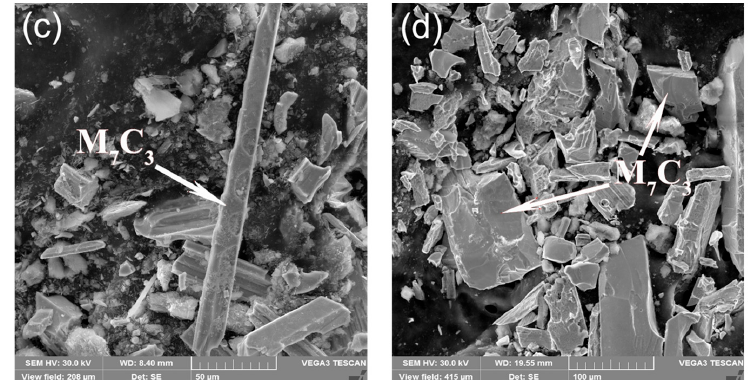
Figure 9. SEM microgrphs of the surface of samples and primary carbides: ( a ) surface of Non-ECP sample; ( b ) surface of ECP sample; ( c ) surface of non-ECP primary carbides; ( d ) surface of ECP primary carbides.